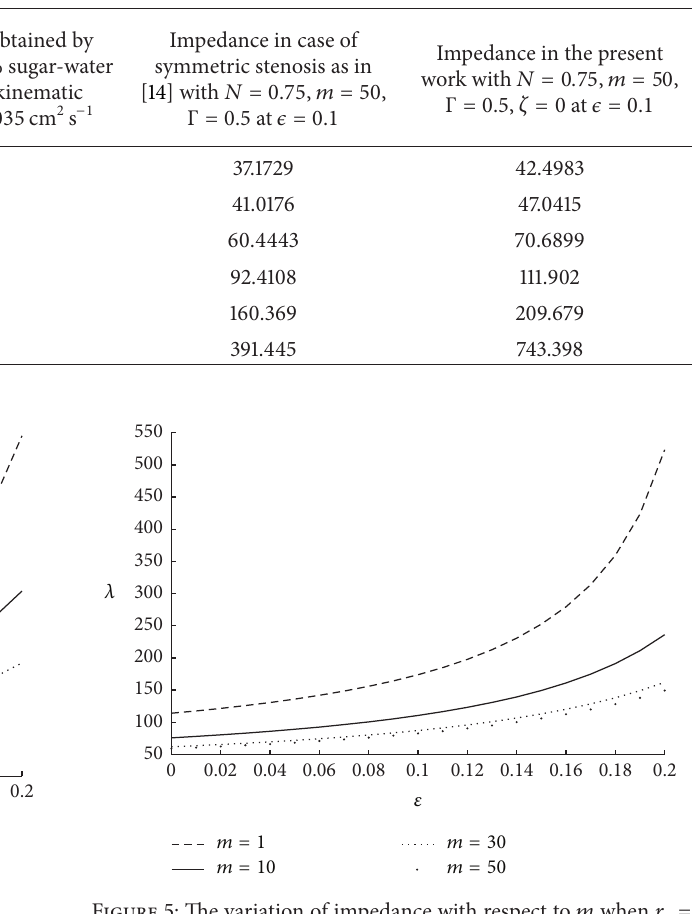
Table 2: Validation with experimental and theoretical results.